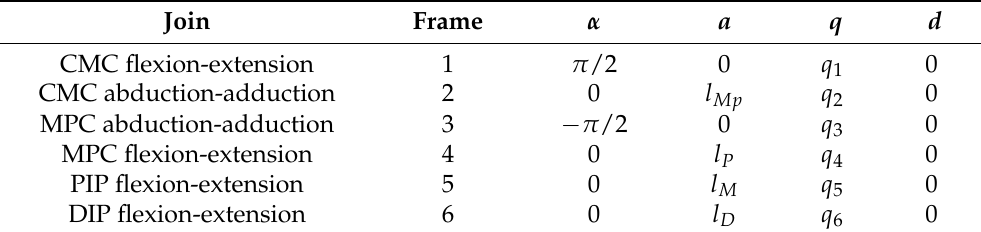
Table 1. Modified Denavit–Hartenberg parameters for each joint. The values for l P , l M , and l D are the length of the proximal, medial, and distal. The l Mp is 10 cm corresponding to the actuator length.